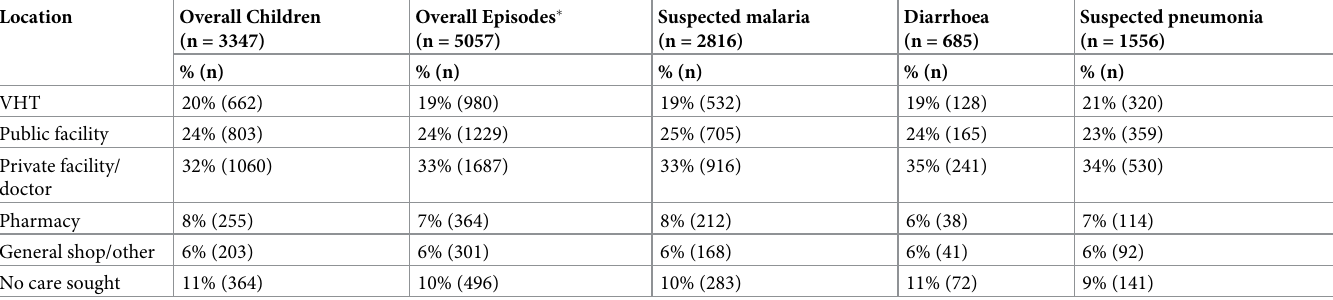
Table 3. First care seeking location for children with suspected malaria, diarrhoea or suspected pneumonia.